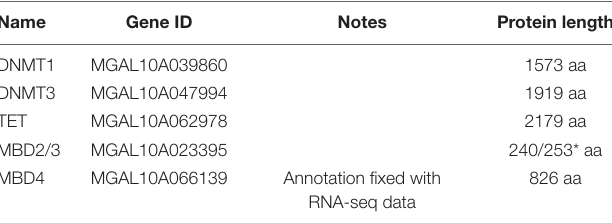
TABLE 1 | List of genes involved in the DNA-methylation machinery in Mytilus galloprovincialis , with gene ID (genome assembly version mg10), protein length, and GenBank accession